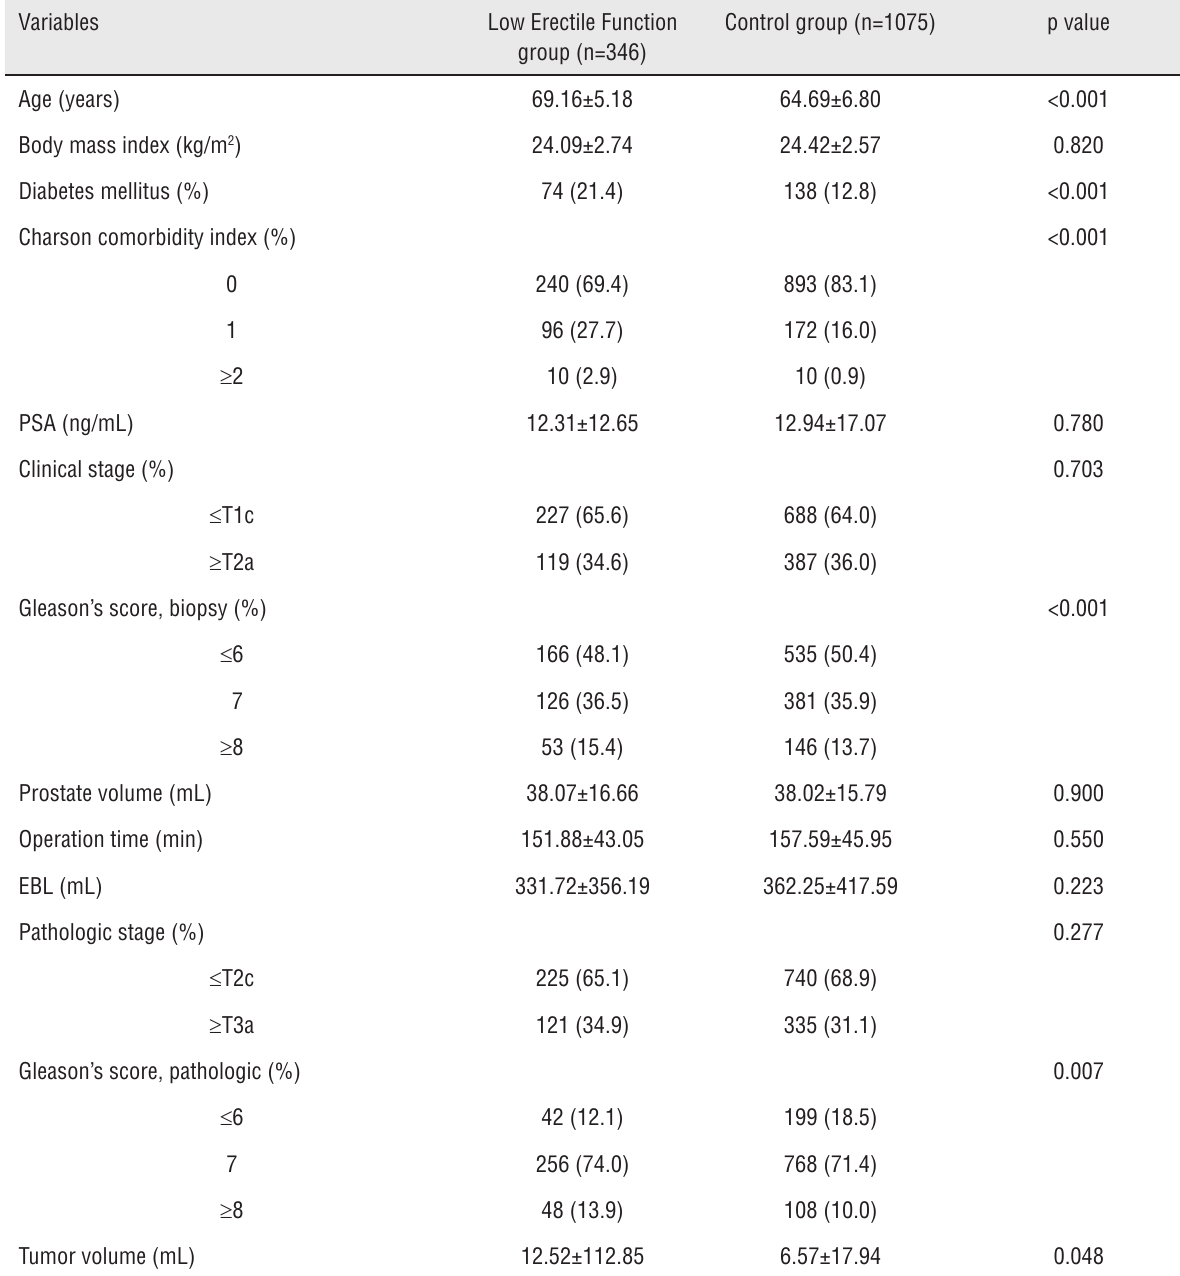
Table-1 - Patient demographics and clinical characteristics stratified by erectile function (<25 percentile, IIEF-5<8 vs. ≥ 25 percentile, IIEF-5 ≥